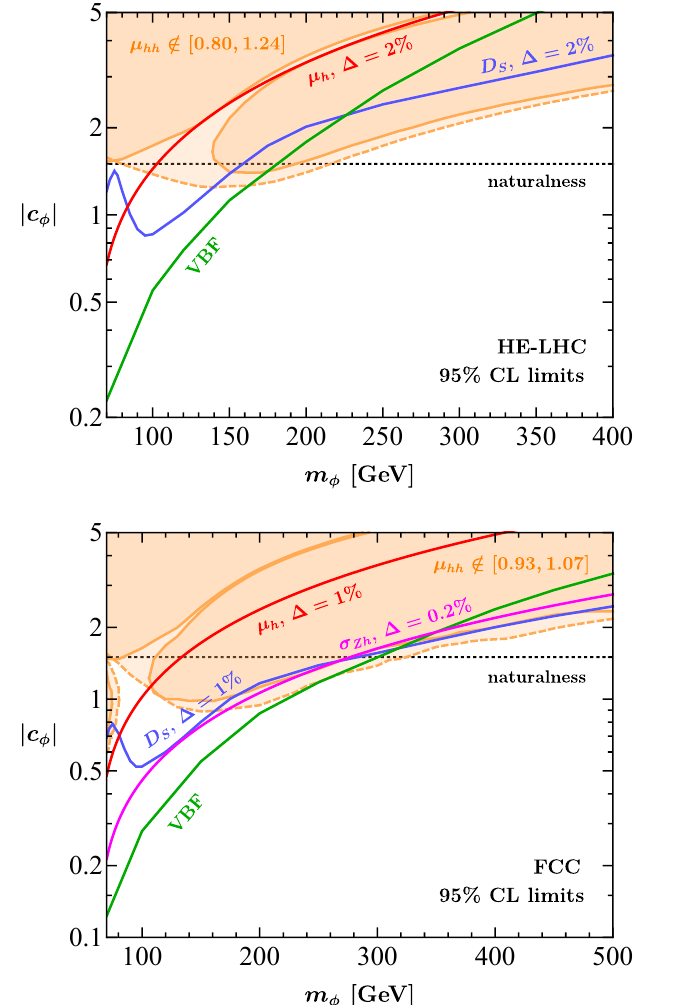
Figure 7 . Comparison of the HE-LHC (upper panel) and FCC (lower panel) reach of different search strategies in the m φ – | c φ | plane. Besides the constraints shown in figure 6 also the 95% CL limit that follows from a precision measurement of the Zh production cross section σ Zh is displayed in the case of the FCC as a solid magenta line. The colour coding and meaning of the other constraints resembles those in the former figure. Consult the main text for additional